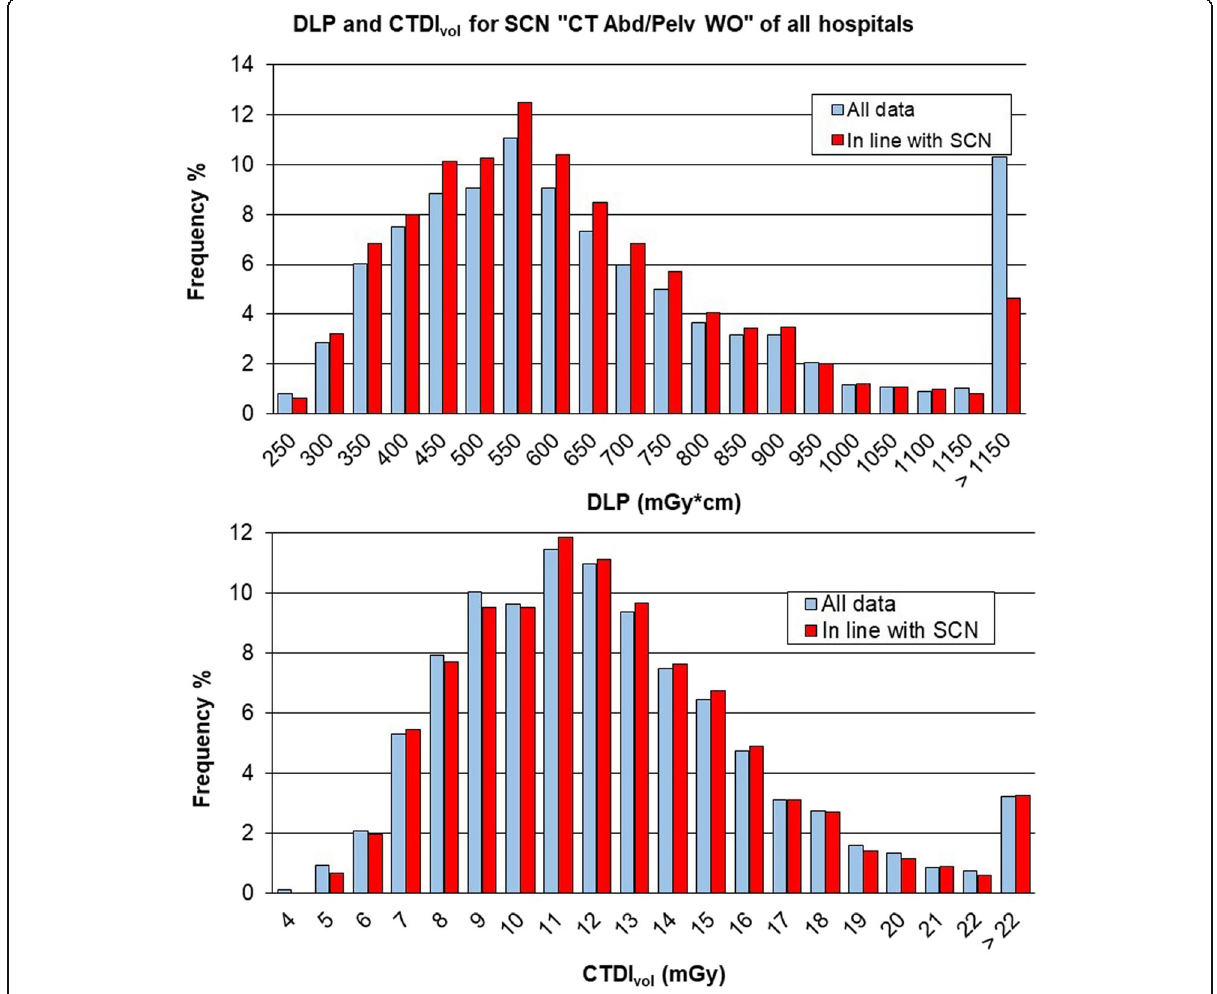
Fig. 9 Comparison between distributions of total dose-length product (DLP) and volumetric computed tomography dose index (CTDI vol ) of the whole data and those in line with the study common name (SCN) “ CT Abd/Pelv WO ” , i.e., studies with all series belonging to that